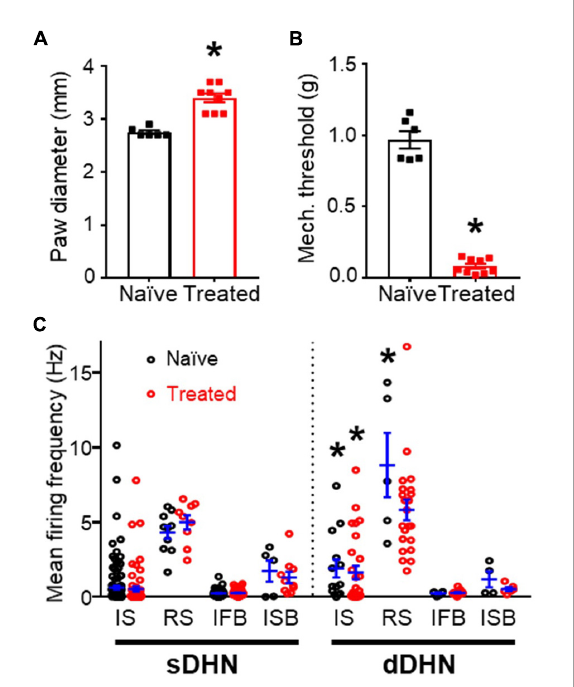
FIGURE1 General comparisons between naïve and treated animals. (A) Effect of inflammation on paw diameter. (B) Effect of inflammation on mechanical withdrawal threshold. Significant differences are marked by * ( p = 0.0004, Mann–Whitney test for panels A,B ). (C) Mean spontaneous firing frequency in the sample of neurons recorded, which comprises different classes of neurons (for this and subsequent figures: IS, single spike; RS, regular simple neurons; IFB, irregular fast burst; ISB, irregular slow burst) from naïve and treated animals in superficial (sDHN) and deep (dDHN) laminae. There was a significant effect of neuronal class on firing frequency in both superficial [F(3, 335) = 87.34; p < 0.0001] and deep areas [ F (3, 90) = 28.28; p < 0.0001; Two-Way ANOVA], no differences were found for treatment and interaction. RS neurons had significantly greater firing frequency than the other types in pairwise comparisons (Tukey’s multiple comparisons post hoc test p ≤ 0.0004). IS and RS neurons had greater firing frequencies in deep than superficial areas as marked by * (Tukey’s multiple comparisons post hoc test, p ≤